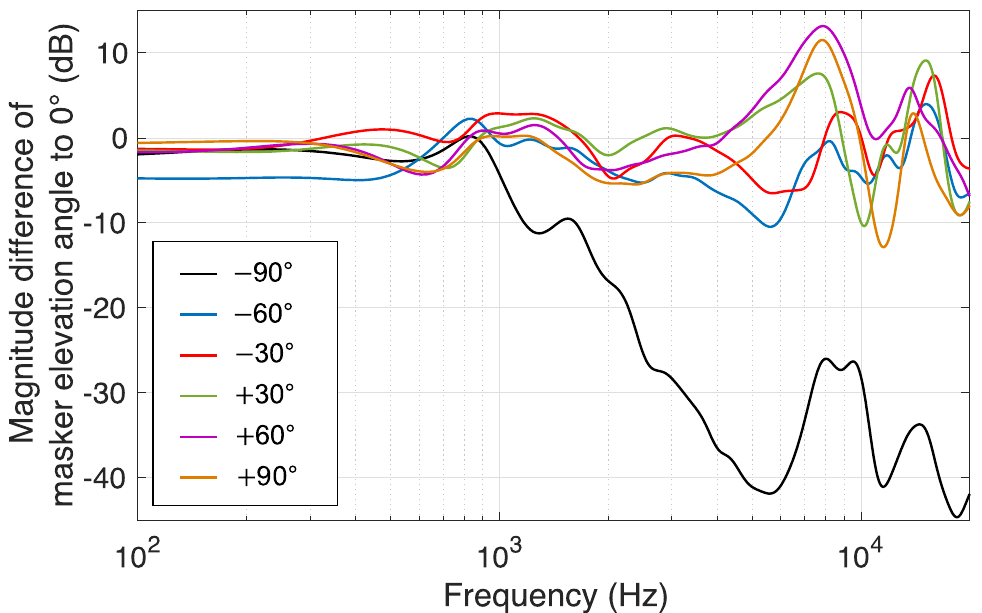
Figure 2. Head-related transfer function (HRTF) difference of each masker position to 0° elevation (reference) using average HRTFs of eighteen human subjects (SADIE II database [16]).